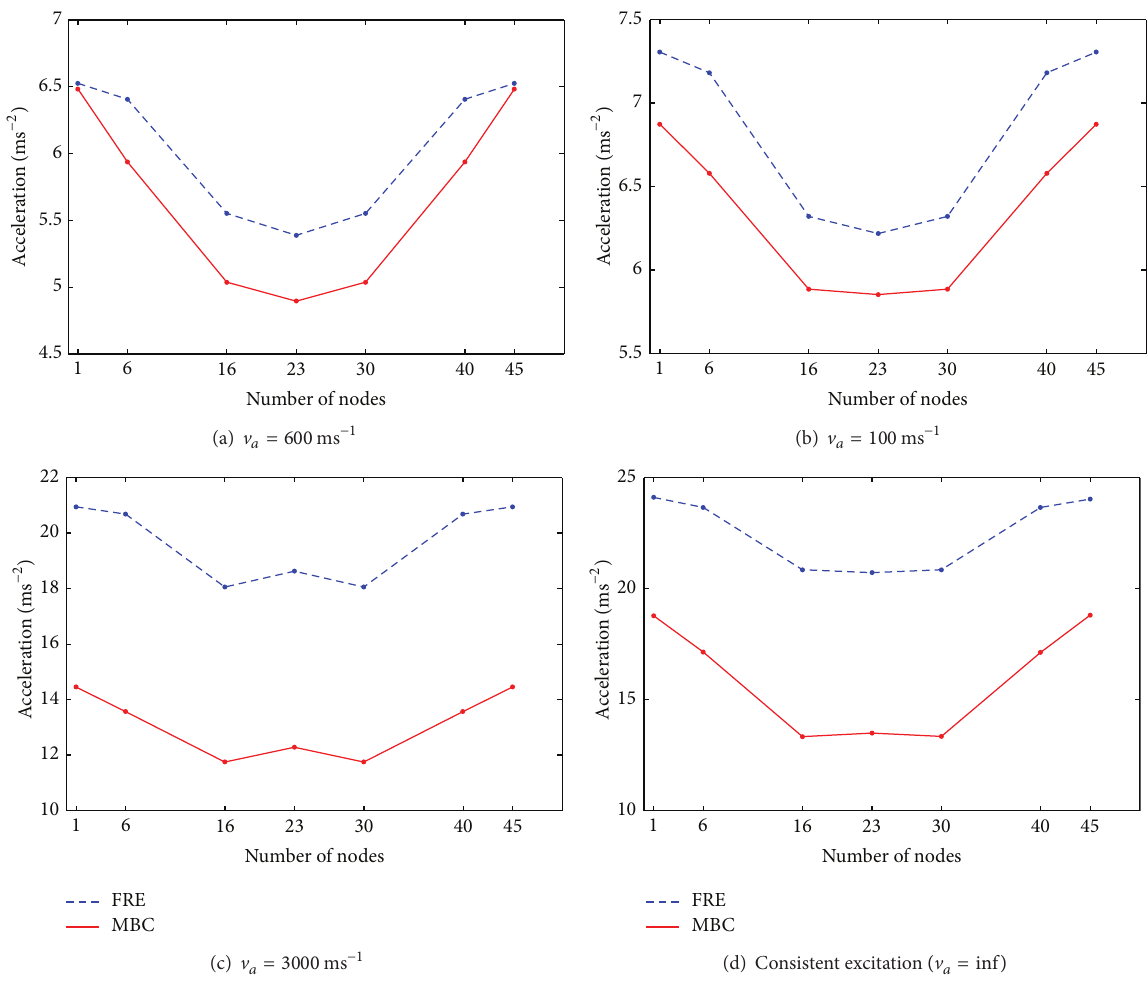
Figure 16: Acceleration response with and without control at various velocities of travelling waves.